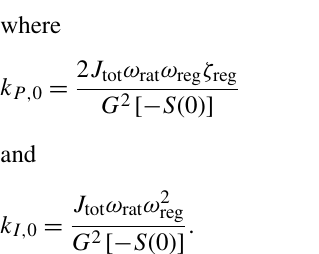
Figure A2. Sensitivity of power to pitch used for gain scheduling the pitch controller for a selection of rotors in this article. The sensi- tivity values obtained from FAST linearizations are fit linearly and used to determine the gain-scheduling parameters for the pitch con-